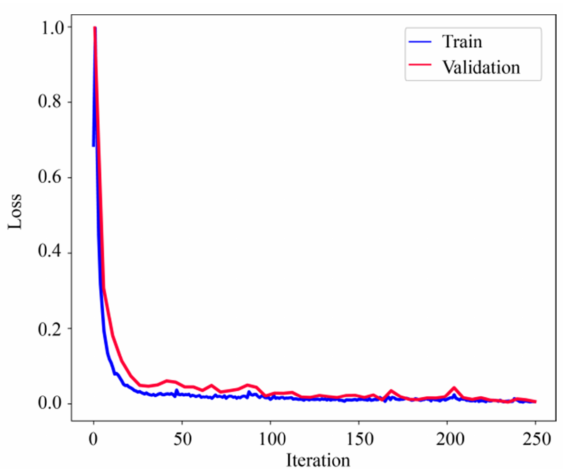
Figure 11. Partially training data set pairs. ( a ) Input shot record with primaries and internal multiples. ( b ) Input shot data without internal multiples.